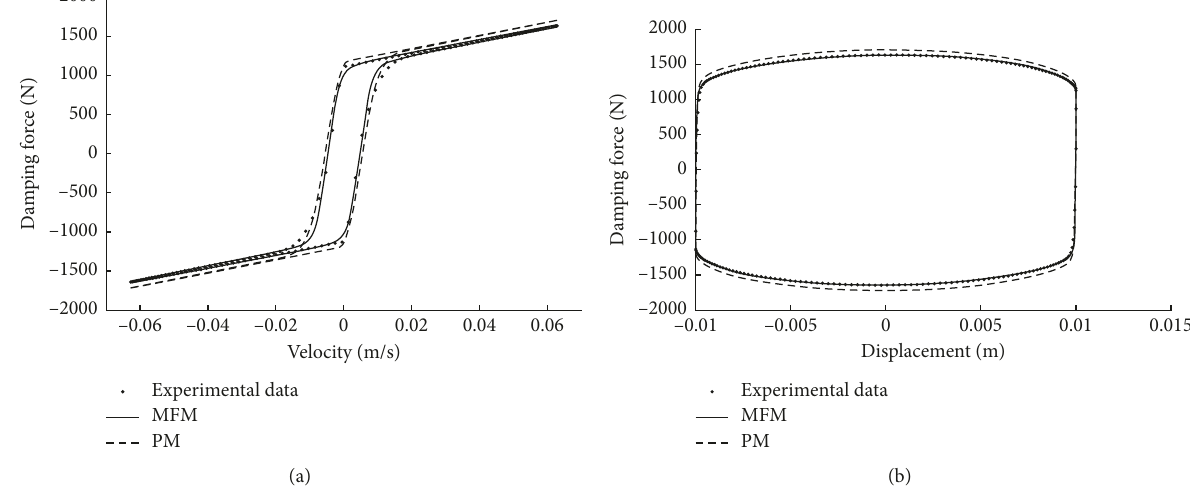
Figure 12: The comparison between MFM, PM, and experimental data when Amp force curve. (b) Piston displacement-damping force curve.